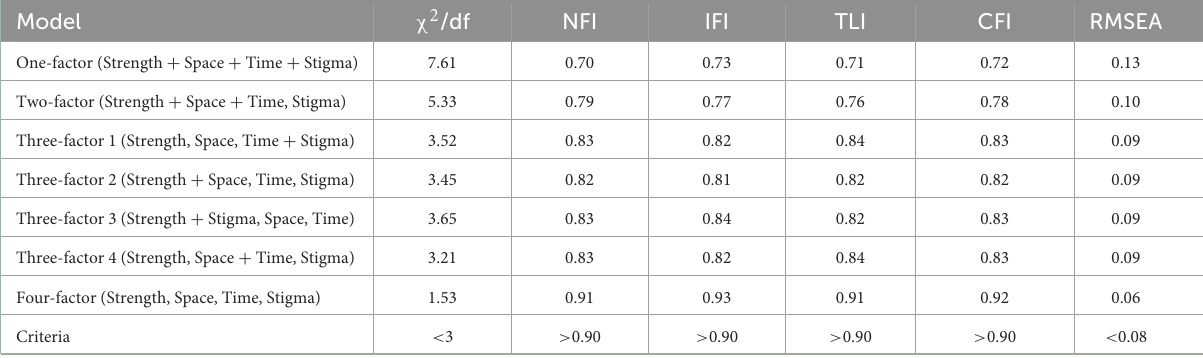
TABLE 2 Confirmatory factor